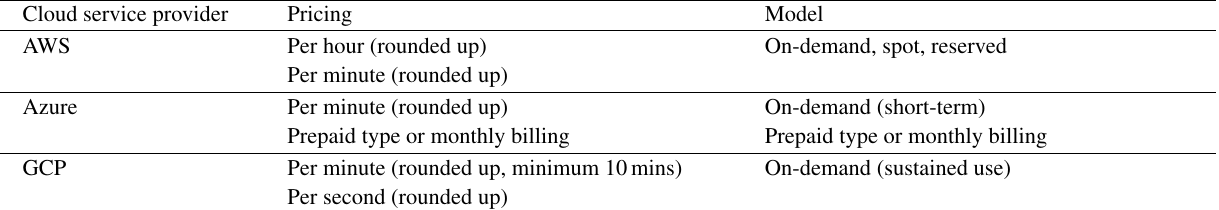
Table 7 Pricing models of the top three